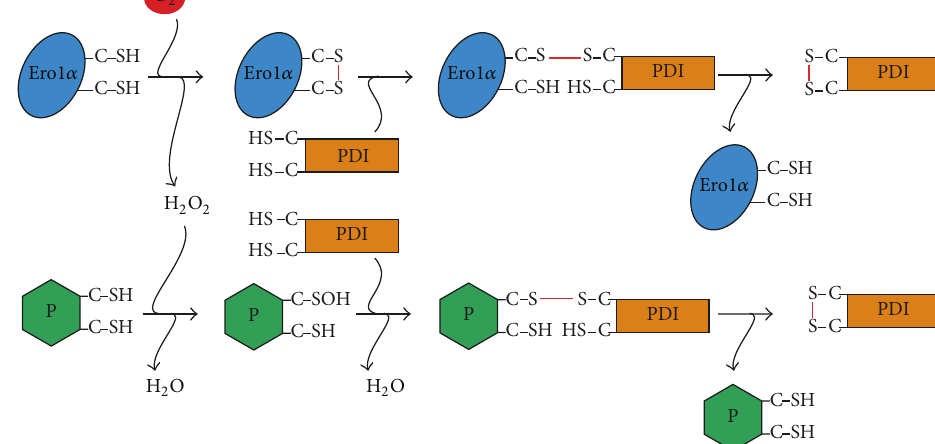
Figure 5: The two-disulfides-out-of-one-O 2 concept. O 2 (red)-mediated oxidation of Ero1 𝛼 results in the generation of one disulfide bond (red), which is transferred to a reduced PDI, and of one molecule of H 2 O 2 . ER-resident peroxidases (P)—probably exclusively of the GPx family (see main text for details)—can couple the reduction of Ero1 𝛼 -derived H 2 O 2 to H 2 O with the introduction of a second disulfide bond (red) into a PDI family member, thereby exploiting the oxidizing capacity of H 2 O 2 .